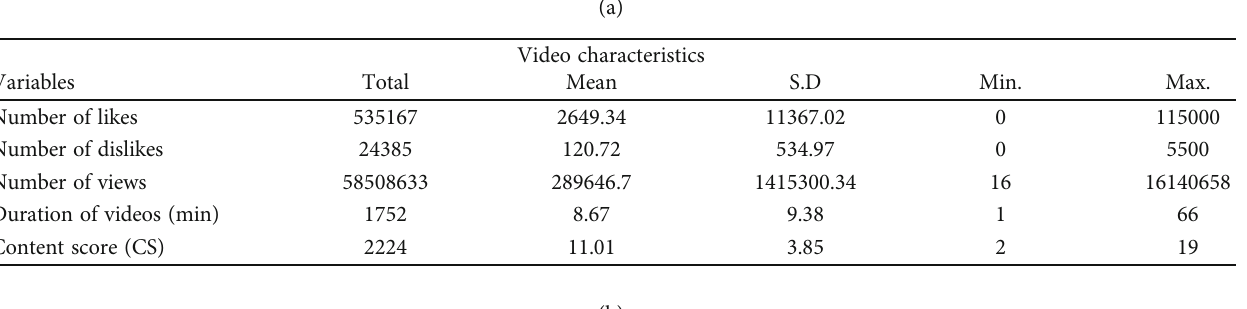
Table 5: Summary of all included YouTube videos on hydroponic